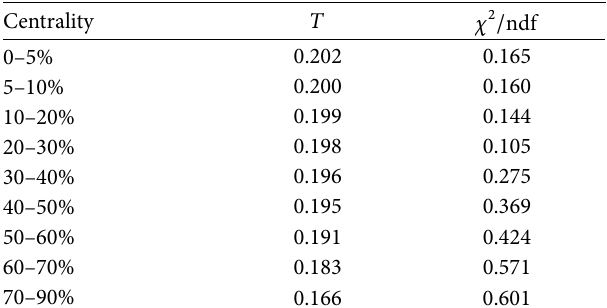
Table 2: Values of parameters used in Figure 1(b). The unit of 𝑇 is GeV.